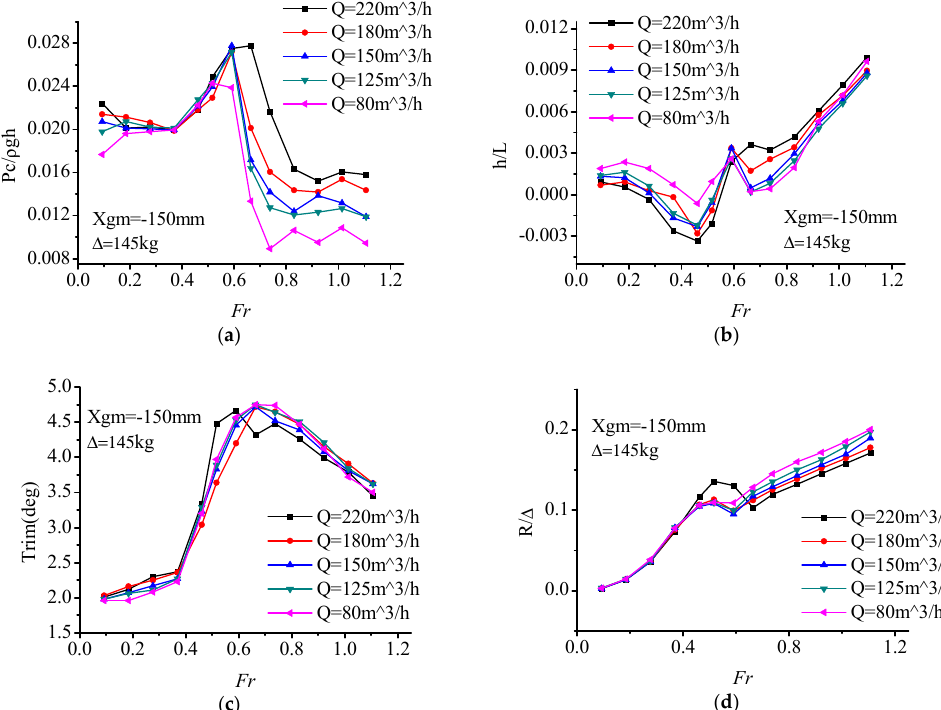
Figure 9. Comparisons of numerical and experimental results with consistent displacement Δ = 145 kg. ( a ) Curves of air cushion pressure; ( b ) Curves of air cushion heave; ( c ) Curves of trim angle; ( d ) Curves of total resistance.